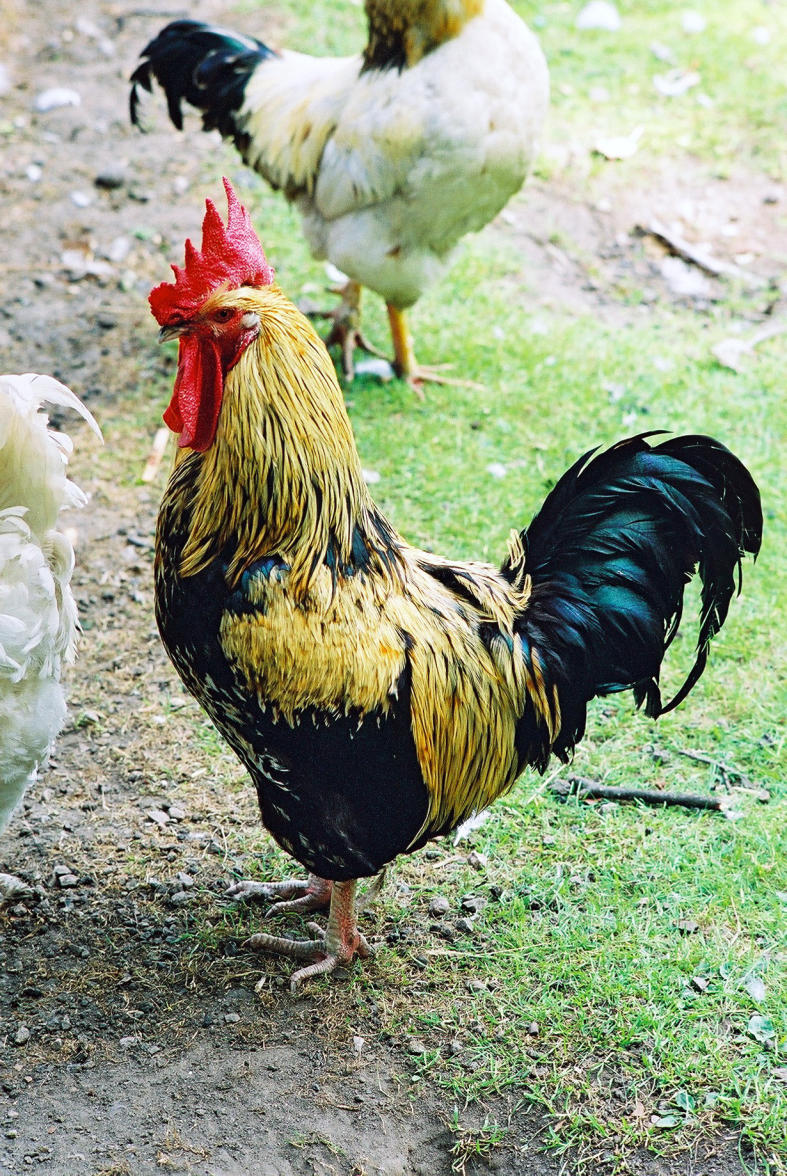
The eye of this chicken possesses two melanopsin photopigments whereas the human eye has only one melanopsin.